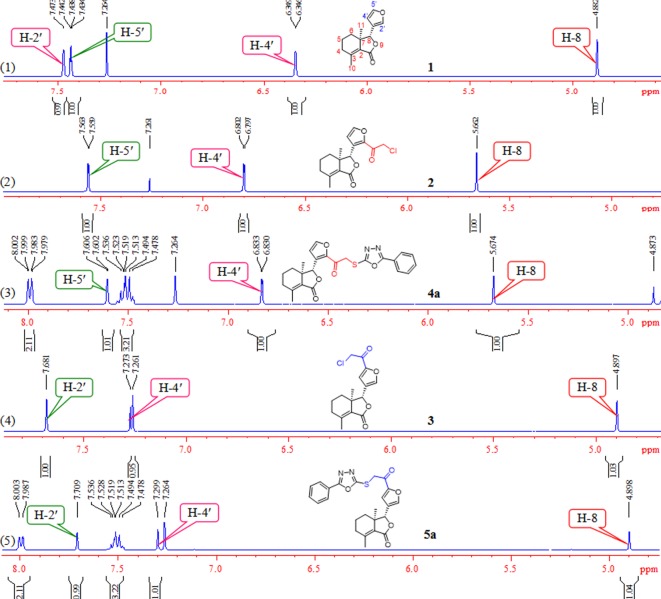
Comparison of partial 1H NMR spectra of compounds 1–3, 4a and 5a.